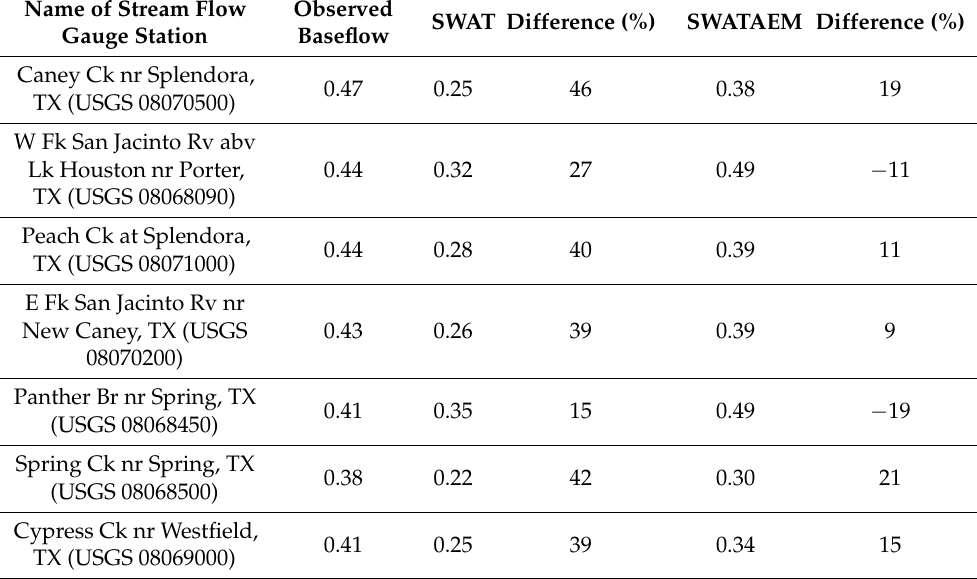
Table 4. Baseflow fraction of stream flow comparison between the observed and simulated hy- drograph at the stream flow gauge Locations (Figure 6) for the original SWAT model and for the SWATAEM